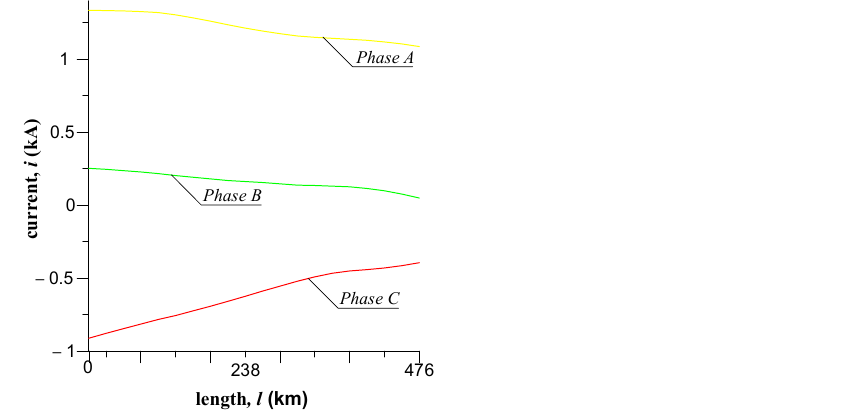
presence of mutual inductances. The phase C voltage at the line’s beginning is − 300 kV, to diminish gradually and reach approximately − 100 kV at the end of the line. The phase current across the line as a function of distance at t = 0.005 s from the time of the voltage turn-on is depicted in Figure 5. Figure 4. Phase voltage across the line as a function of distance at t = 0.005 s.